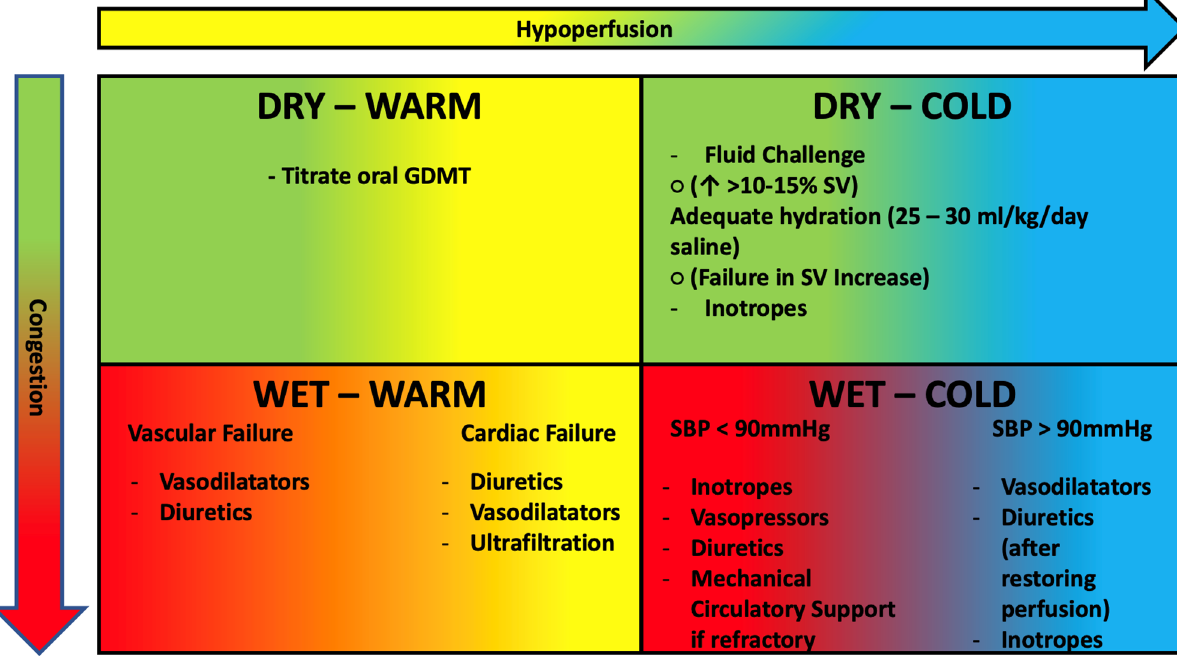
Figure 3. Clinical profiles of AHF patients based on congestion and hypoperfusion. See text for further treatment information. GDMT, guideline directed medical therapy; SV, stroke volume; SBP, systolic blood pressure. DBP, diastolic blood pressure. Green: Dry. Red: Congested. Yellow: Warm. Blue: Cold.